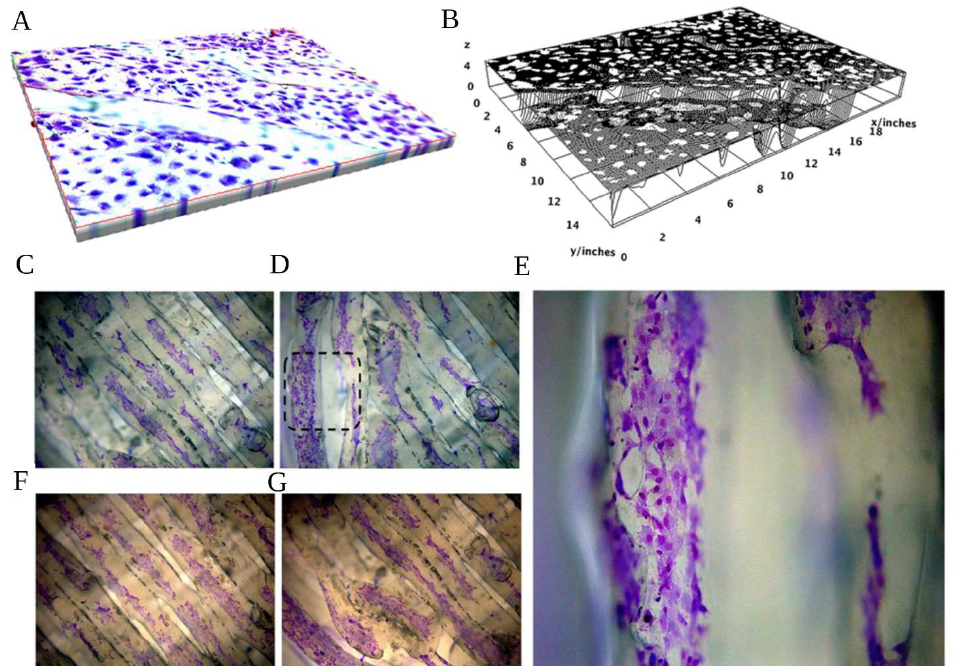
Figure 6. ( A ) Spatial representation of the poly( ε -caprolactone) (PCL) compounded with beta-tricalcium phosphate 20% (PCL+ β -TCP 20%)-based biomaterial with toluidine blue-stained preosteoblasts, magnification 20×. ( B ) Surface plot of the PCL+β-TCP 20% compounds with the relevant expansion of white dots (pre-osteoblasts) on almost the whole surface. ( C ) Toluidine blue staining of preosteoblasts expanding on the central meshes or the peripheral ( D , E ) meshes of the compound, magnification 20× ( C , D ) and 40× ( E , as magnification of black dashed square of D ). The hematoxylin/eosin staining of the proliferating preosteoblasts on the biomaterial network better elucidates the affinity of the compound with the developing cells in the centre ( F ) or peripheral parts of the substrate ( G ). level comparable to that of the culture plates (Figure 7).